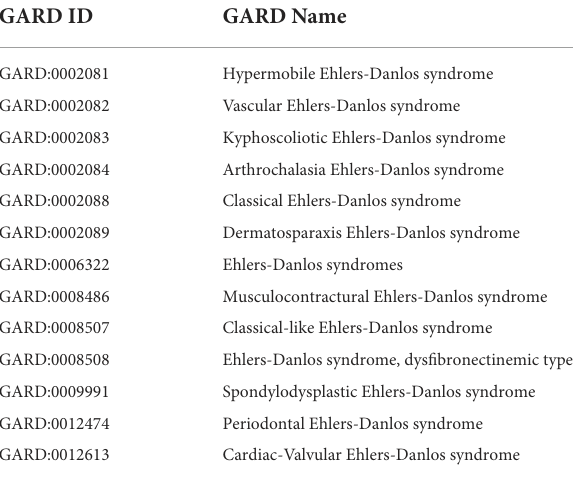
TABLE 4 Thirteen types of “Ehlers-Danlos